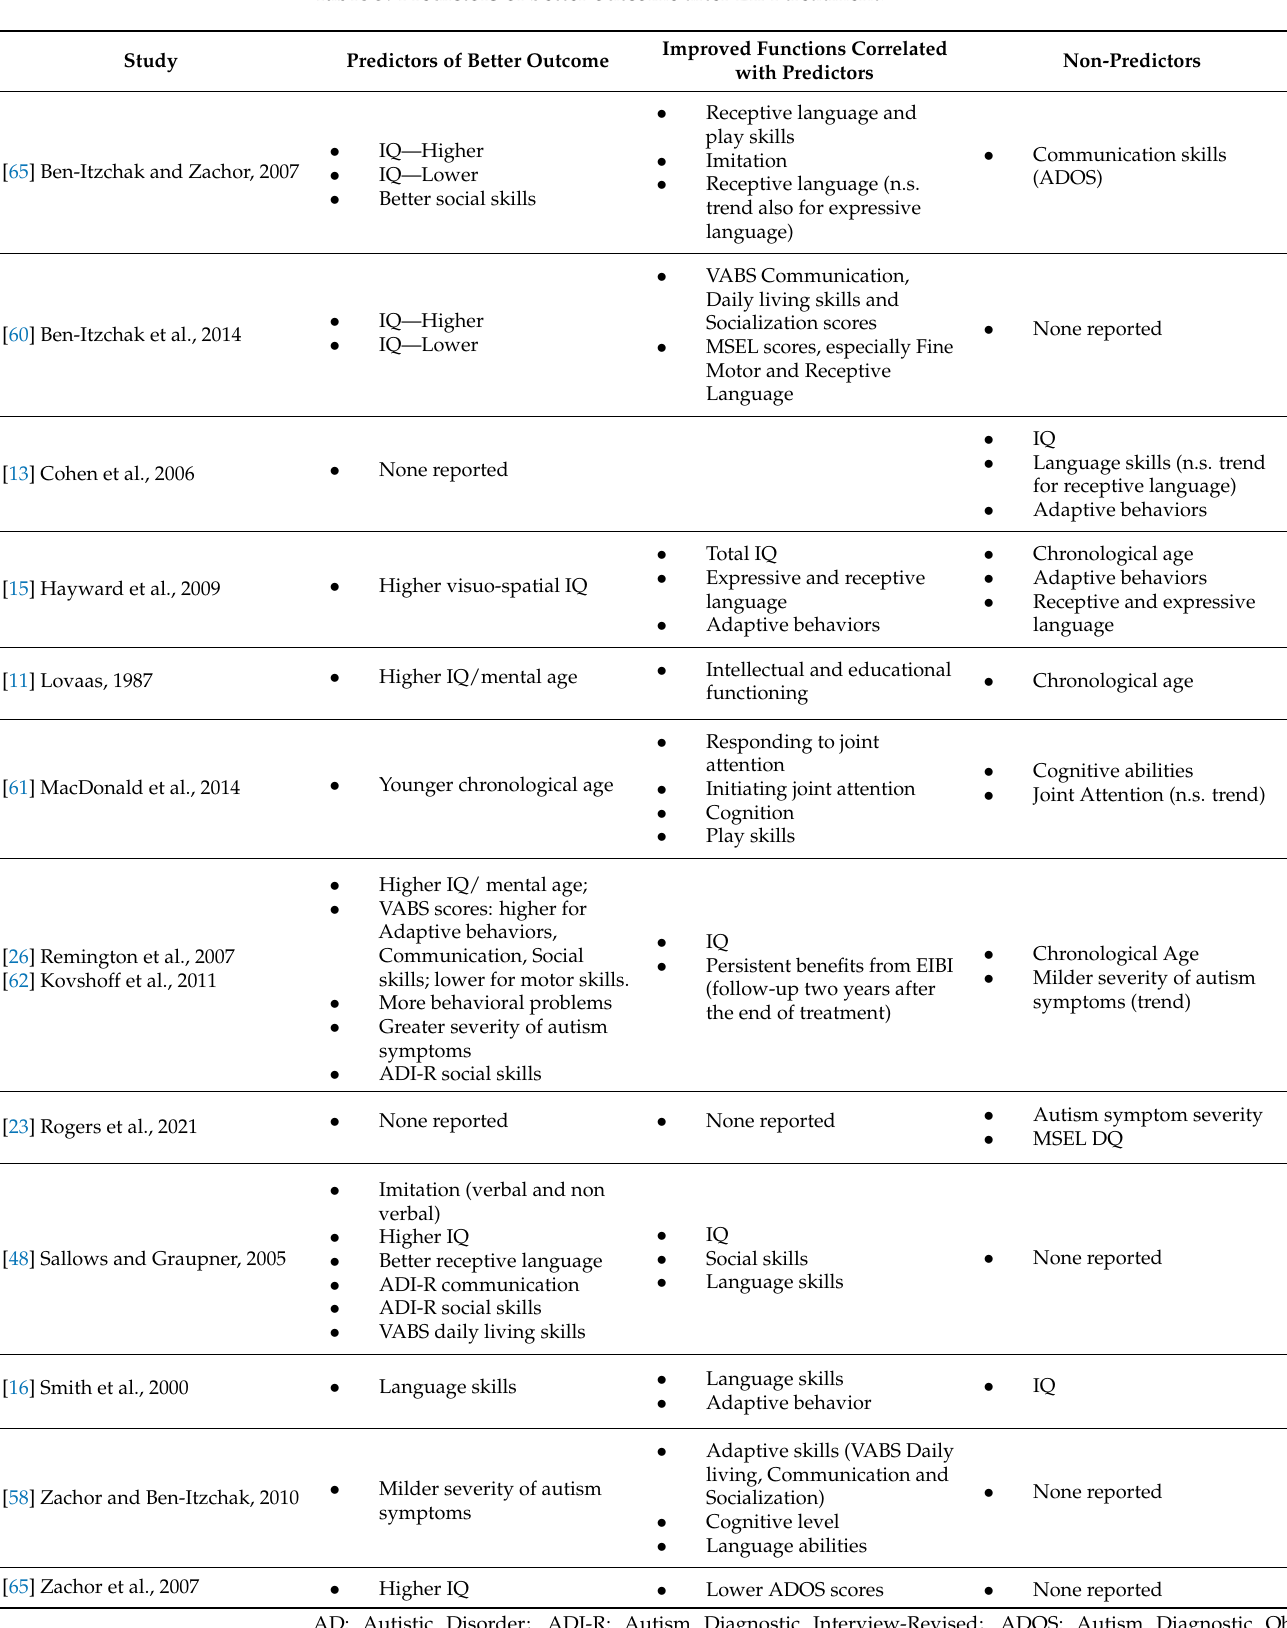
Table 3. Predictors of better outcome after EIBI